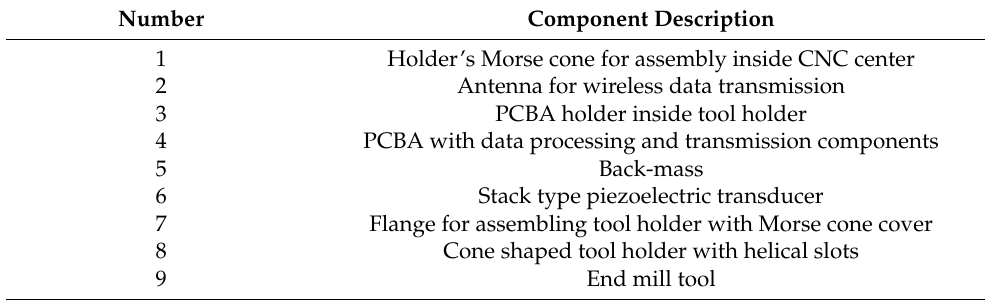
Table 2. Components constituting a condition monitoring device for a rotating shank type tool.